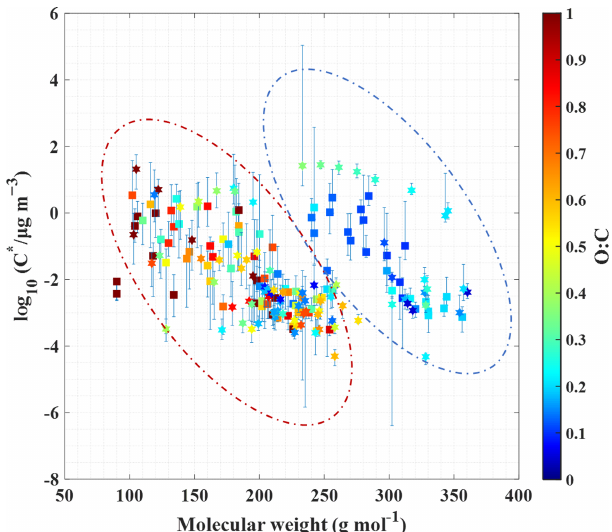
Figure 4. Saturation mass concentration of CHO and CHON com- pounds against their molecular weights, as color-coded by the O / C ratios. Note that compounds with an O / C ratio equal to or greater than 1.0 are marked with the same color. The CHO and CHON compounds are denoted by squares and hexagrams, respectively. Whiskers denote 25th and 75th percentile values of measured satu- ration mass concentration from 30 ambient samples, and whiskers are ultimately due to variability in the measured T max of CHO and CHON compounds. Dashed ellipses group compounds on the basis of the O / C